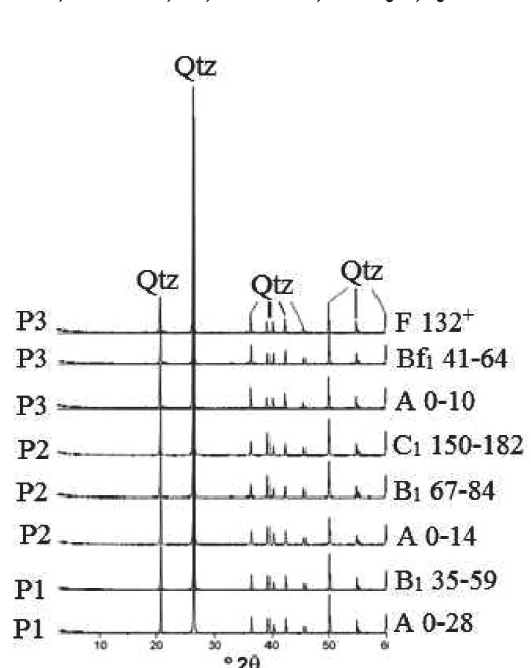
Figure 2. X-ray diffractogram of clay fraction of the A and B1 horizons, the A, B1 and C1 horizons, and the A, Bf1 and F layers of the well-drained P1, P2 and P3 profiles, respectively: Kt, Kaolinite; Gb, Gibbsite; Gt, Goethite; and Qtz, Quartz.